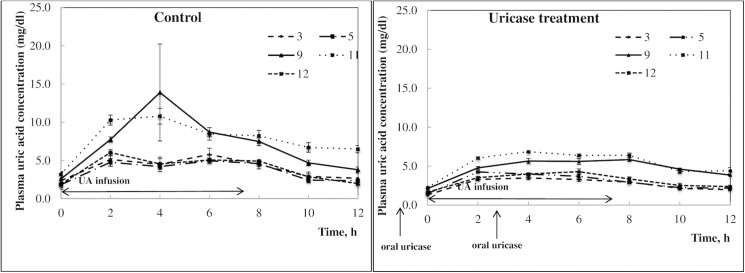
A, B. Plasma uric acid concentrations in 9/10 nephrectomized pigs i.v. infused with a uric acid suspension (every 30 min for 7.5 h, 5 mg/kg b.w.), without (control period–A) or with (uricase treatment period–B) oral uricase treatment during the first 12 h after beginning the uric acid infusions. Data are presented as means ± SD of both CT (control-treatment) and TC (treatment-control) sequences for each pig separately, n = 5 (each pig served as its’ own control).